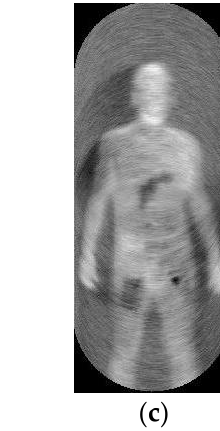
Table 1. The experiment